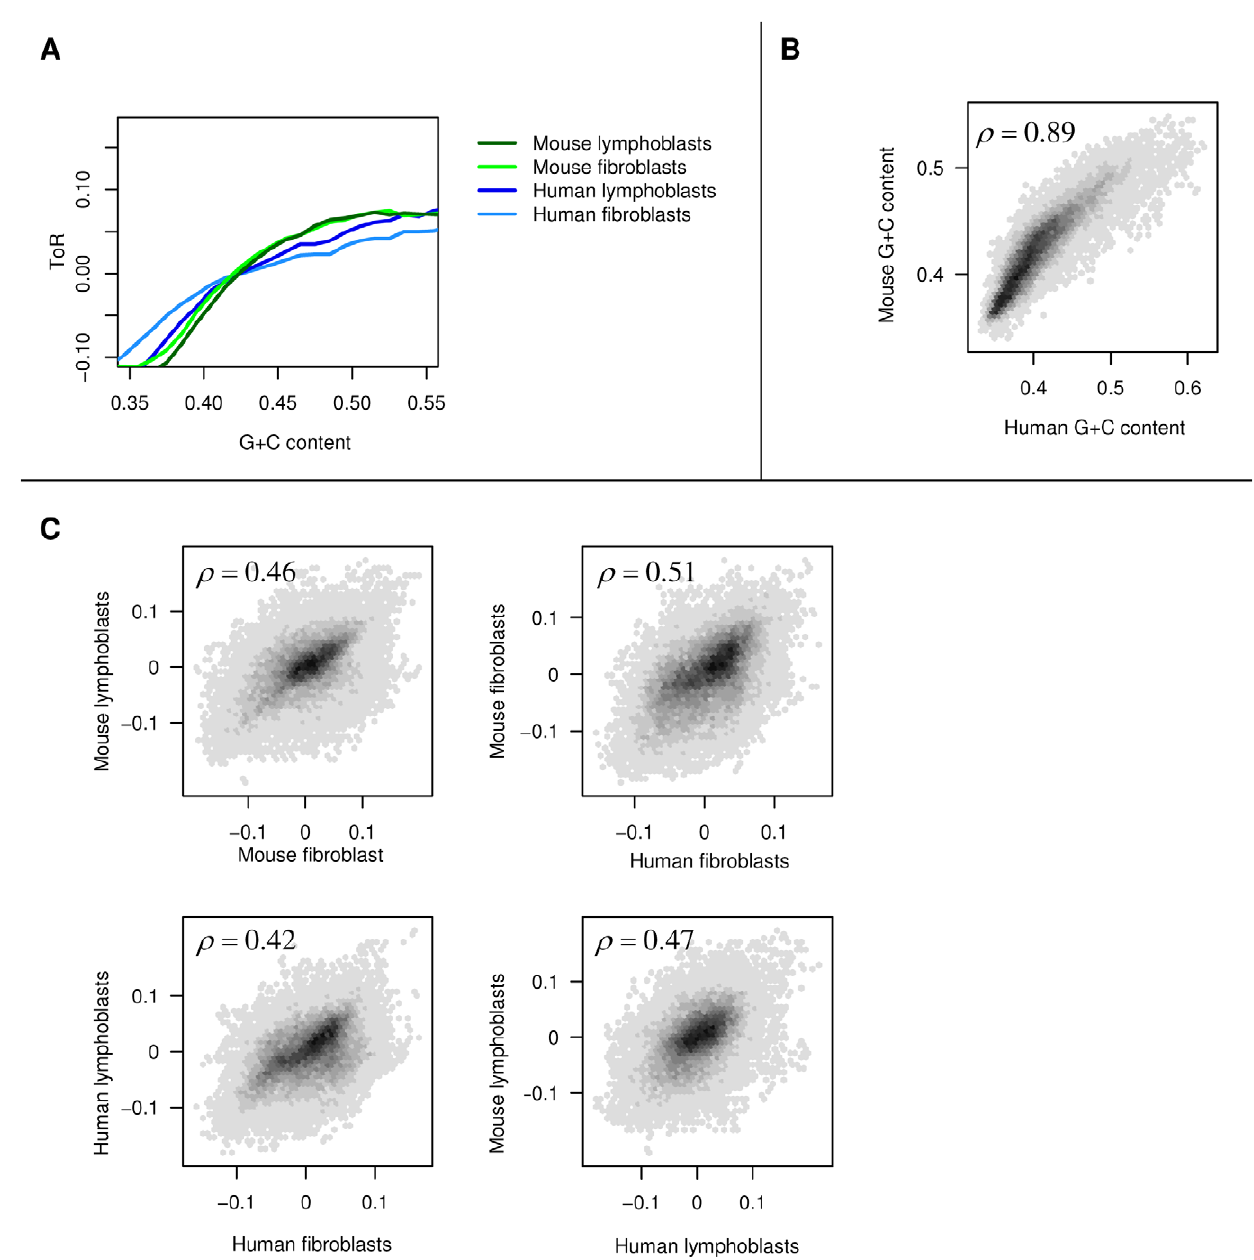
Figure 2. G + C content conservation does not explain ToR conservation. (A) Fitting ToR to G + C content. Shown are moving averages of ToR as a function of G + C content (in 50Kb bins) for the four ToR profiles (using 50 equal-sized G + C content bins ranging between 0.2 and 0.7). (B) Conservation of G + C content between human and mouse. Shown are G + C content in 50Kb segments of orthologous human and mouse genome segments. Spearman correlation is given on the plot. (C) Residual ToR is conserved. We computed the residual ToR (see Materials and Methods) for each of the experiments by subtracting the G + C to ToR trend (depicted in 2A) from the original ToR value. The residual profiles therefore lack any correlation to the regional G + C content. Shown are two-way comparisons among the residual profiles, demonstrating highly significant ToR correlation even after the G + C correlation has been normalized. divergence encompass a territory that is much larger than the scope of a single fork. Importantly, despite these specific cases, genome rearrangements are not causing massive divergence of replication timing, and the overall replication structure is largely We focused next on fusion events in the mouse lineage that conserved between human and mouse, suggesting evolution involve segments that are distal (located more than 5Mb apart or typically shuffles ToR domains rather than breaking and fusing on a different chromosome) in both human, dog and rhesus. We observed that these events preferentially involve early replicating them.